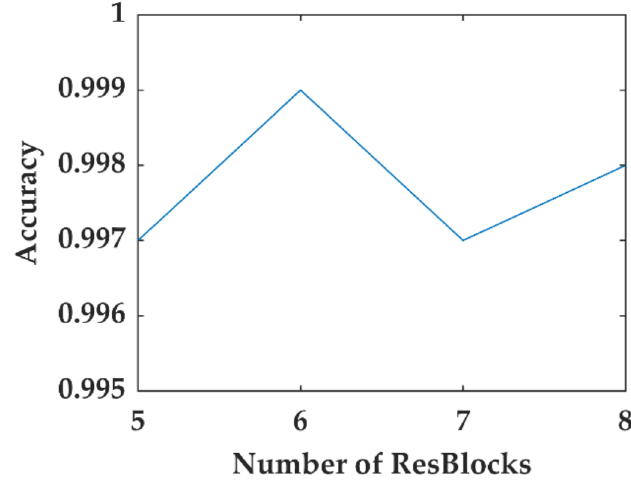
Figure 9. Accuracy of different numbers of ResBlocks in Testset1.